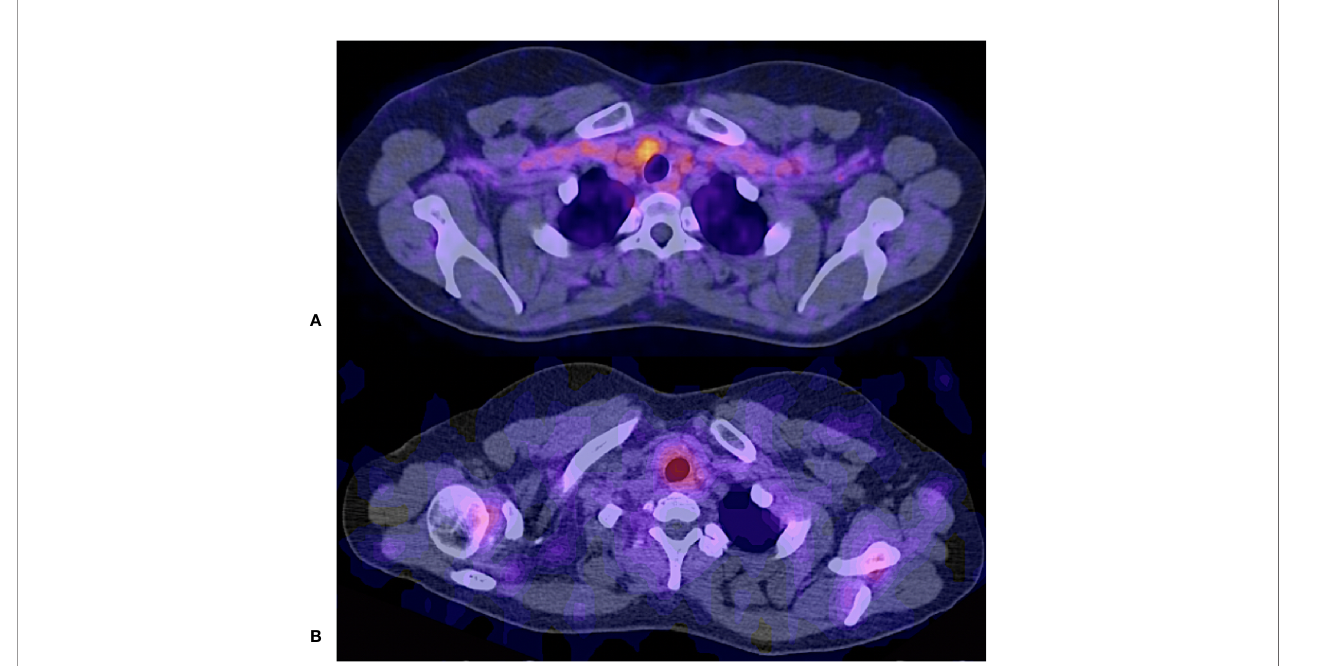
FIGURE 7 | Fused hybrid images (A) 68 Ga PSMA PET/CT shows focal radiotracer uptake in the cervical level VI located adenopathy. (B) 131 I – SPECT/CT shows diffuse radiotracer uptake in the same